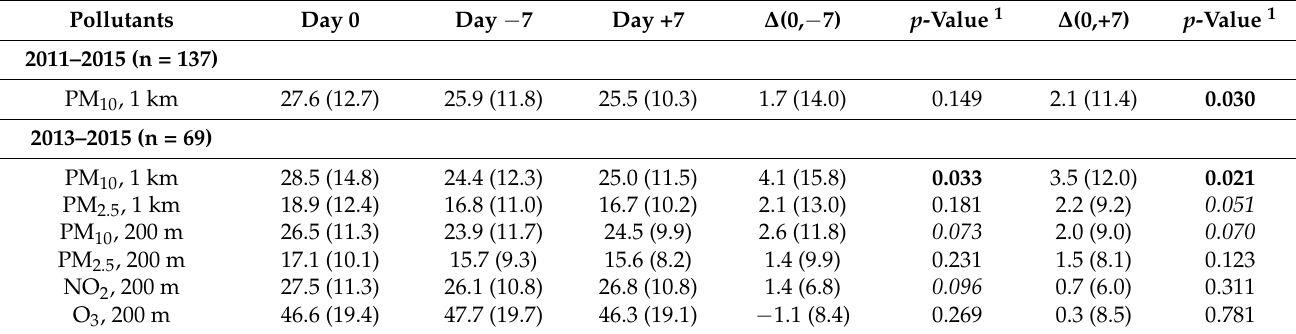
Table 3. Mean (SD) estimated pollutant concentrations ( µ g/m 3 ) on the case days (day 0) and on the control days (day − 7 and day +7), for the whole period (2011–2015) and for the sub-period (2013–2015).